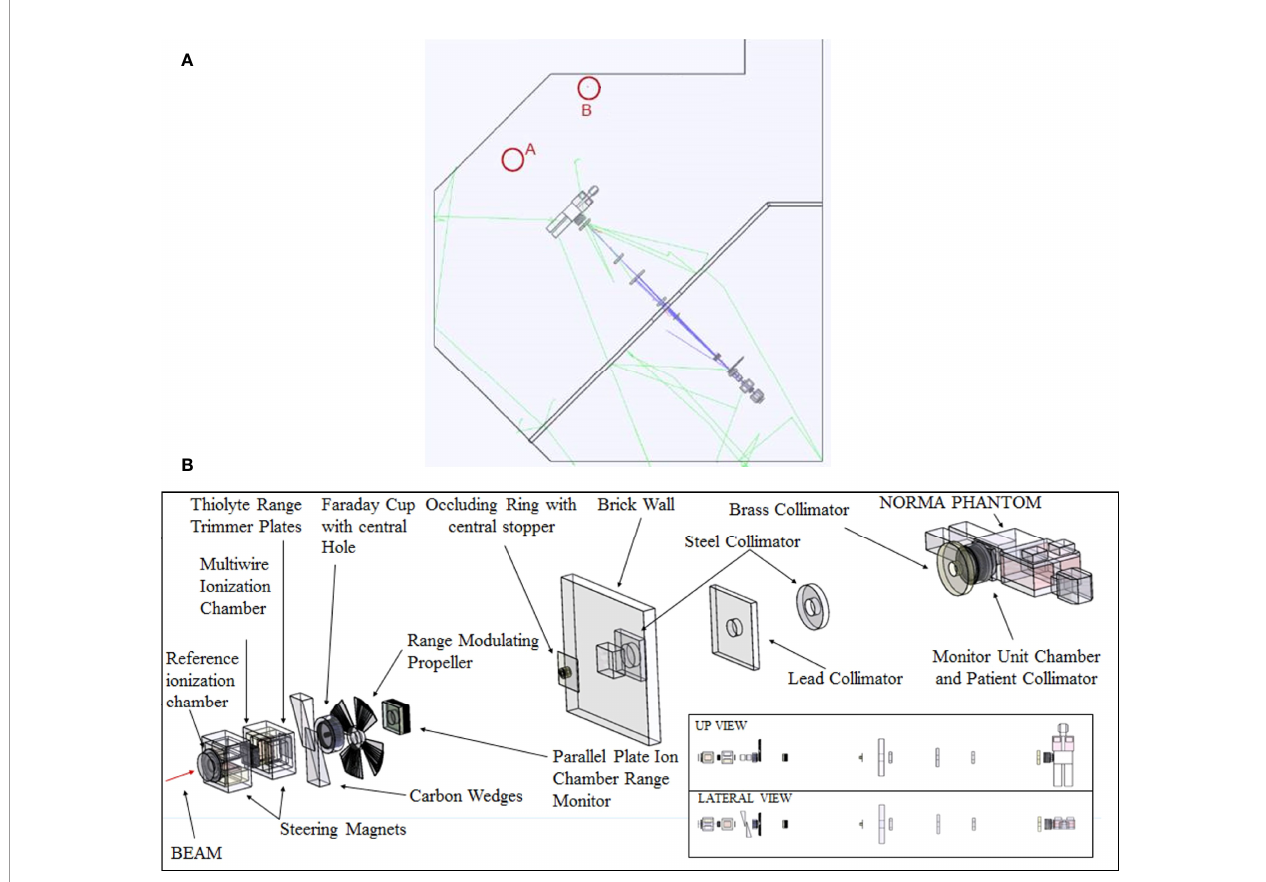
FIGURE 2 | (A) Sketch of the treatment room with the points selected for BSS experimental measurements and MC simulations. Point A is located in the beam direction, downstream 2.33 m after the isocenter. Point B is 3.4 m away from the isocenter ~60° with respect to the beam line, downstream and to the right side. (B) Beam elements simulated in MC together with the NORMA phantom inside the treatment room. Room walls are not shown for